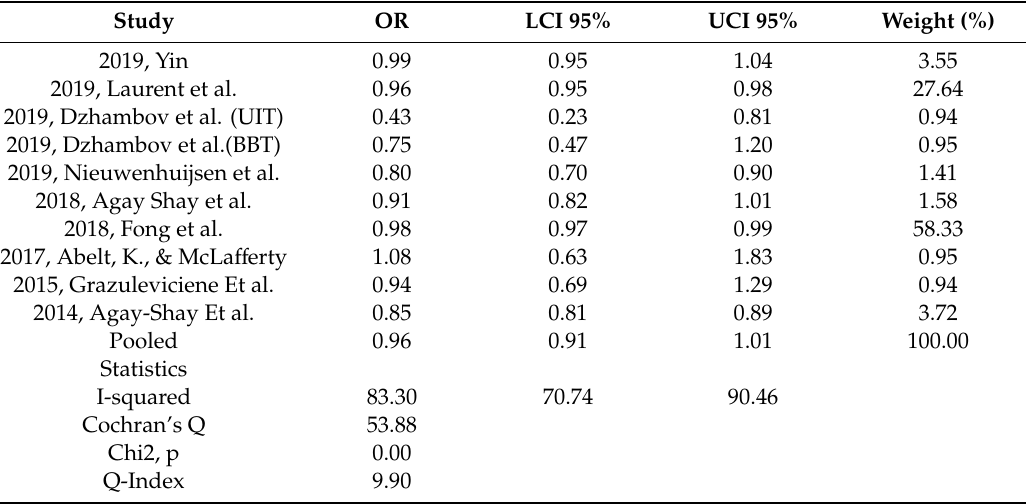
Table 3. Meta-Analysis Results for the effect of NDVI increase on low birth weight (odds ratios,